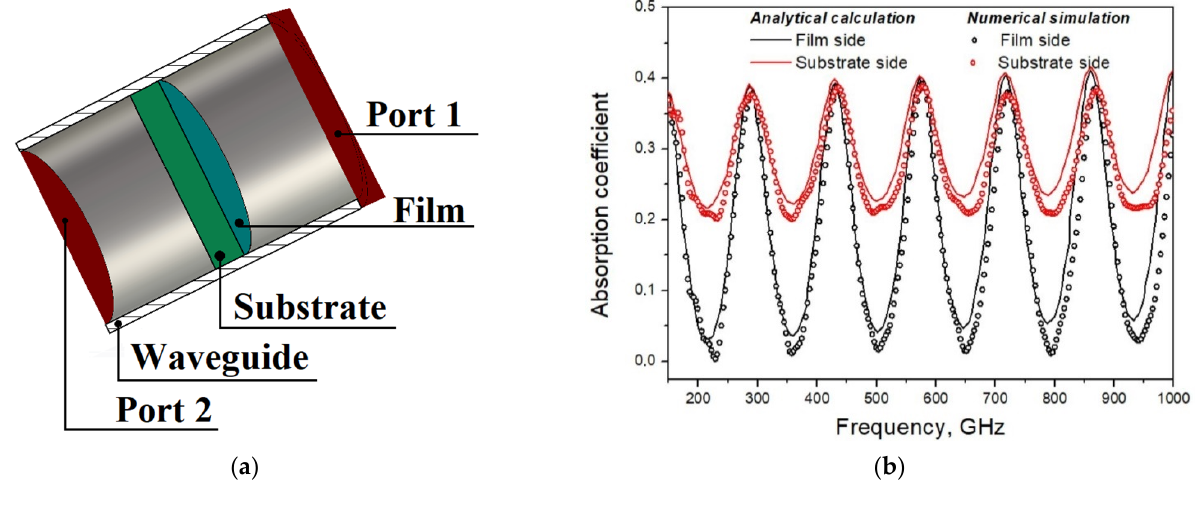
Figure 1. Methods of modeling absorption coefficient: ( a ) schematic image of modeled project (cross-section); ( b ) results of modeling for film with resistance of 550 Ω / □ on 340 μ m sapphire substrate and comparison with calculation of same film from [6] (Reprinted with permission. Copyright 2021 Lemzyakov, S.A.).